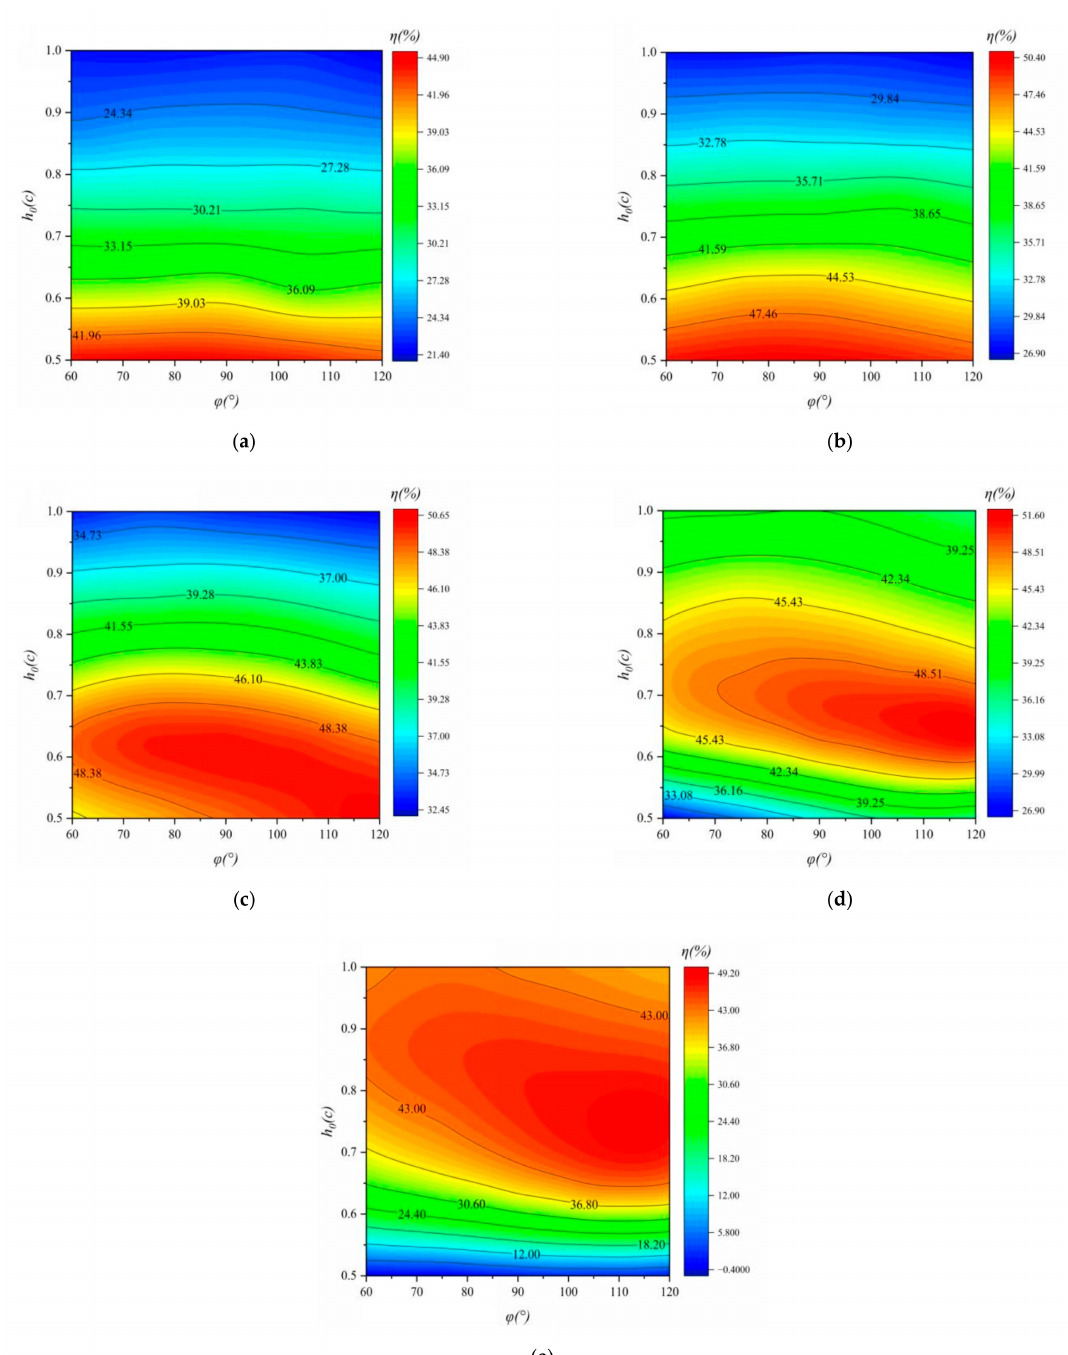
Figure 13. Variation of propulsion efficiency with the phase difference between heave and surge